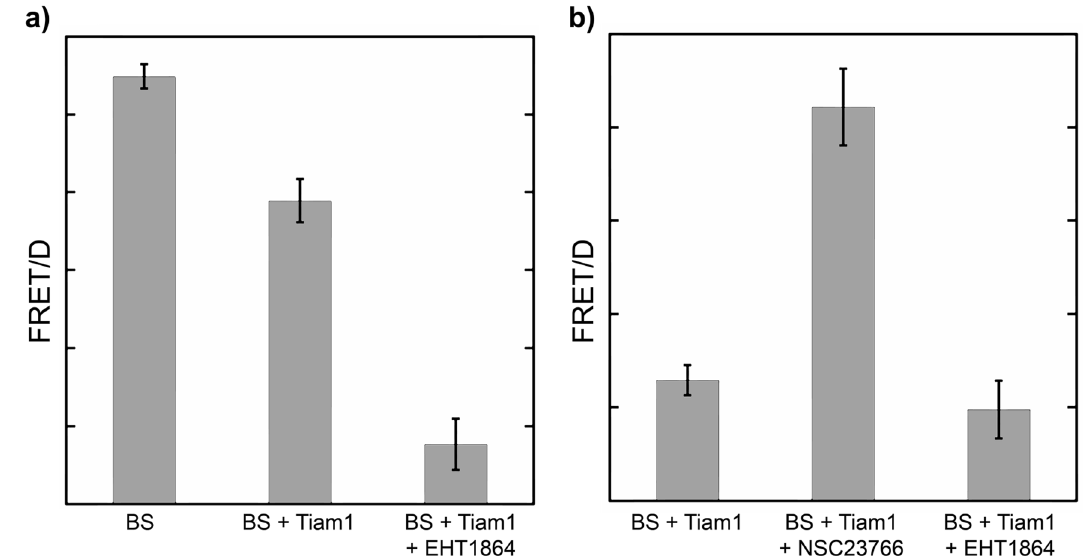
Figure 4. LRET robustly detects chemical inhibition of Rac1 activitation in 96-well plates. ( a ) 293 T cells expressing a LRET Rac1 biosensor (30 nm ER/K linker) alone (BS) or with Tiam1 (BS + Tiam1) were grown overnight in 96-well plates, then incubated with. Time-gated measurements were obtained following 4 h incubation with EHT 1864 (50 µM, 0.5% DMSO) and addition of a lysis buffer containing TMP-TTHA-cs124. ( b ) 293 T cells co-expressing the sensor and Tiam1 were grown in 96-well overnight with or without inhibitors in the media. Time-gated measurements were taken after adding the lysis buffer as in ( a ). Bar graphs depict mean FRET/donor (FRET/D) ratios measured for each condition. Error bars, sem (n ≥ 3 transfections/plates; 16 wells/plate for each